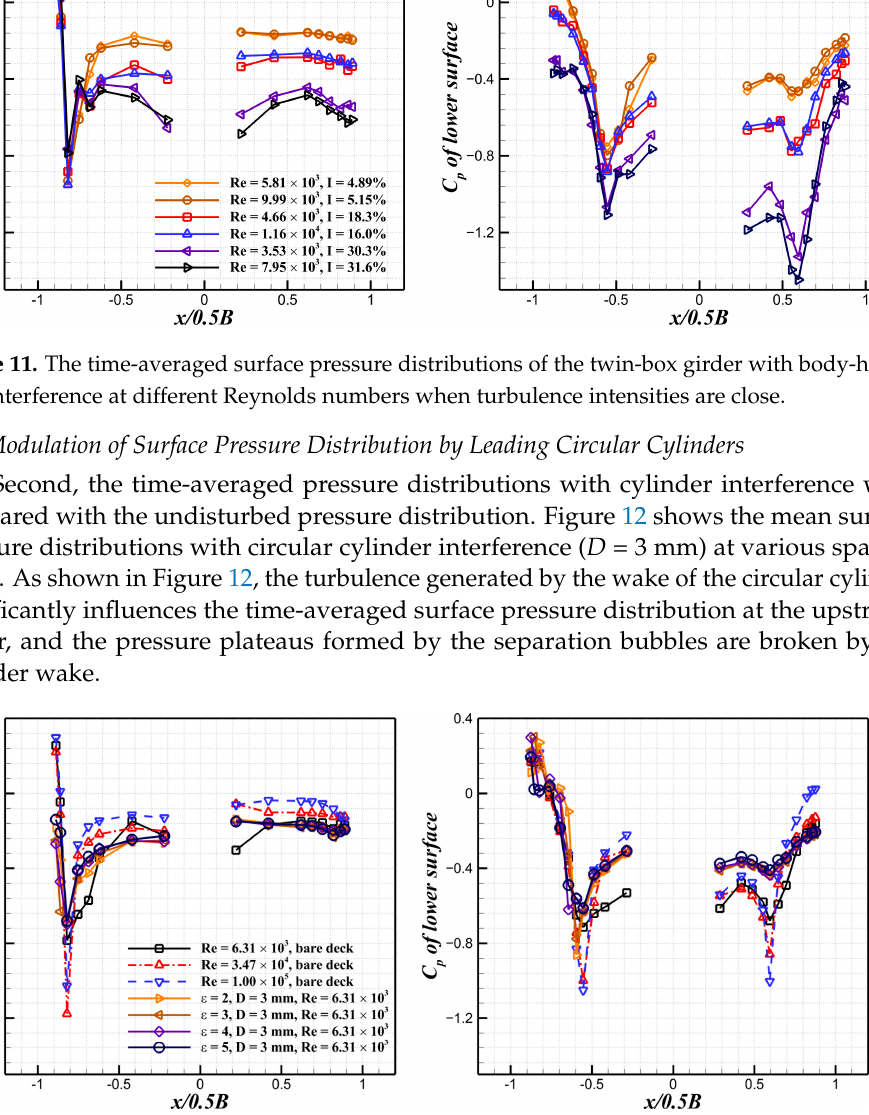
Figure 10. Comparisons of the time-averaged surface pressure distribution of the twin-box girder with body-height grid interference and bare deck.